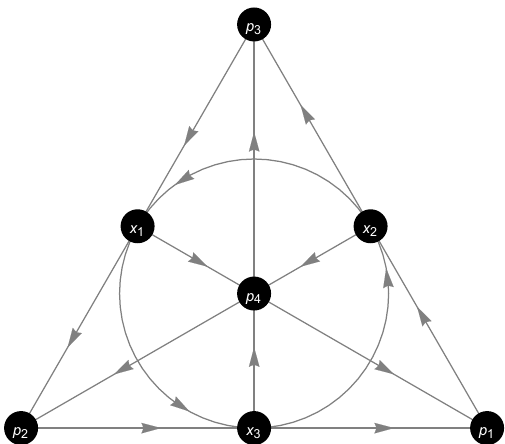
Figure 2 . Commutation relations of the nonassociative magnetic monopole algebra. The commu- tator of two phase space coordinates is given by the third node along the line connecting the two. If the arrow points from the (cid:12)rst to the second element of the commutator, one has a factor of i on the right-hand side, otherwise (cid:0) i